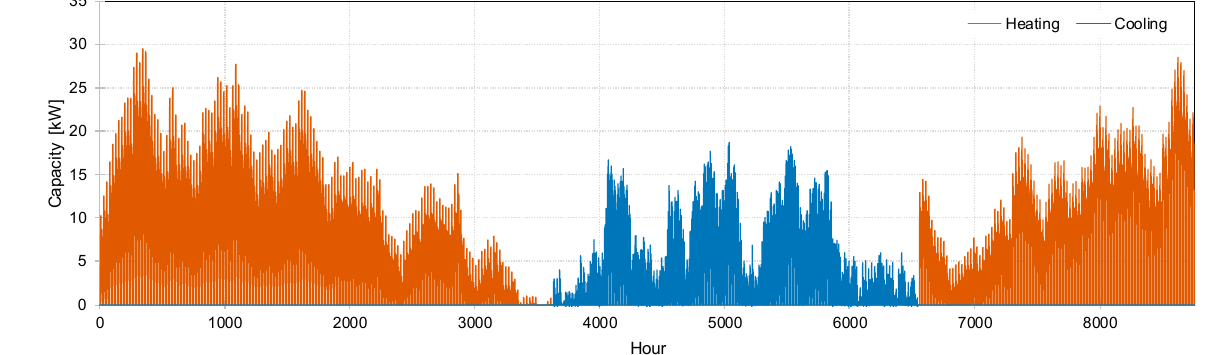
Figure 3. Useful energy for heating and cooling calculated for location Senj (TRY). Figure 4. Daily variation of design load for heating ( left ) and cooling ( right ).